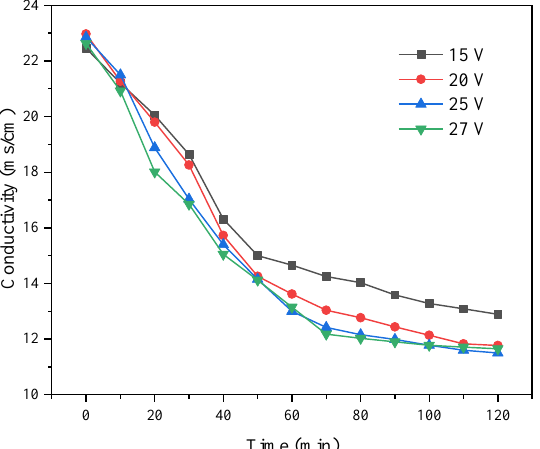
Figure 15. Conductivity of the fresh cells with different voltage changes with time.